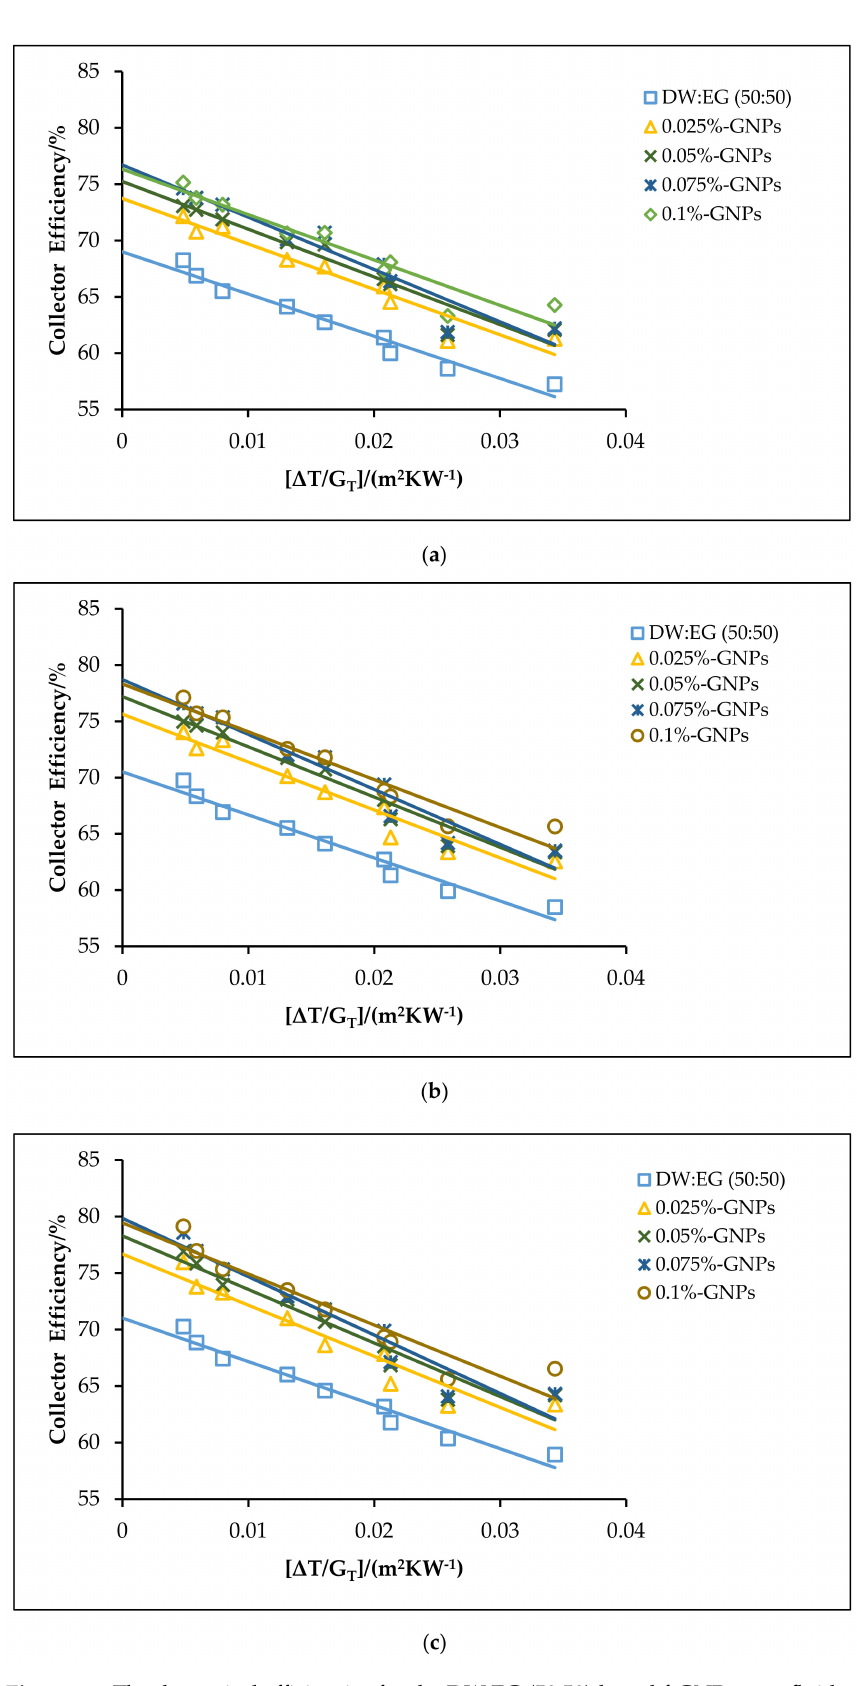
Figure 12. The theoretical efficiencies for the DW:EG (50:50)-based f-GNPs nanofluids with different weight concentrations: ( a ) 0.5 kg min − 1 ; ( b ) 1 kg min − 1 ; ( c ) 1.5 kg min − 1